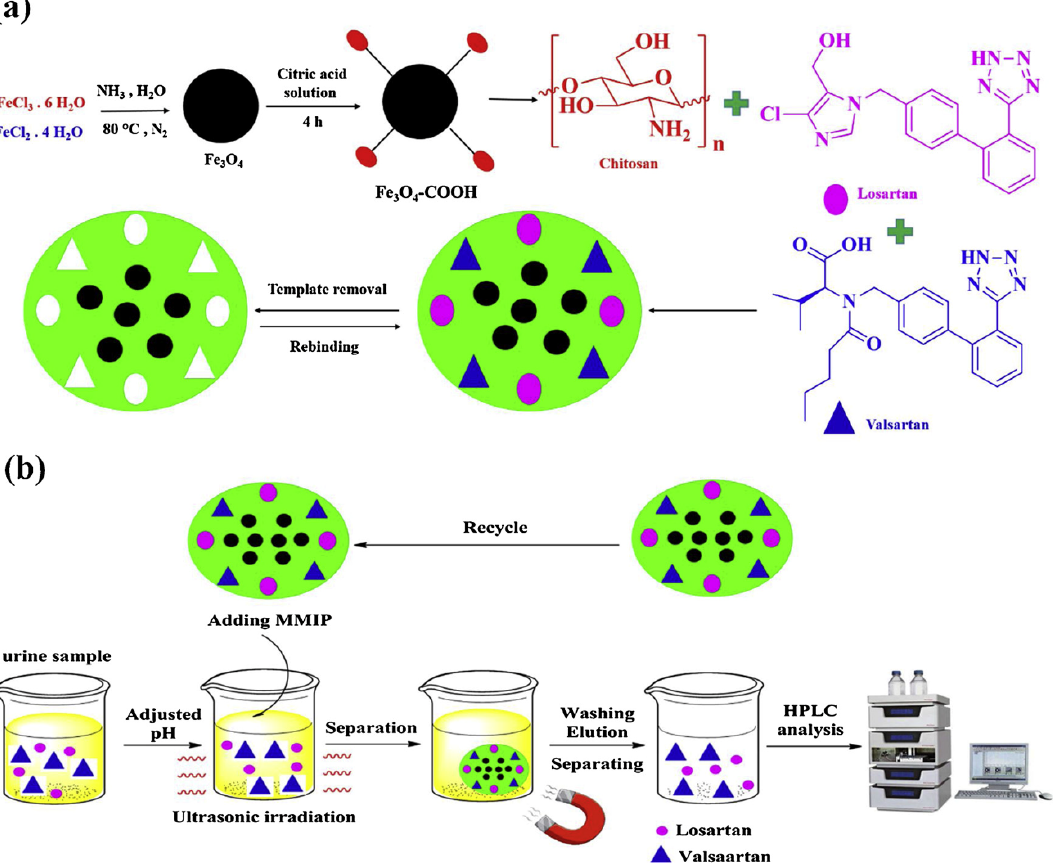
Figure 2. Synthesis procedure of magnetic MIP ( a ) and magnetic MIP for valsartan and losartan extraction ( b ). Reproduced from the work in [49] with permission from Elsevier.